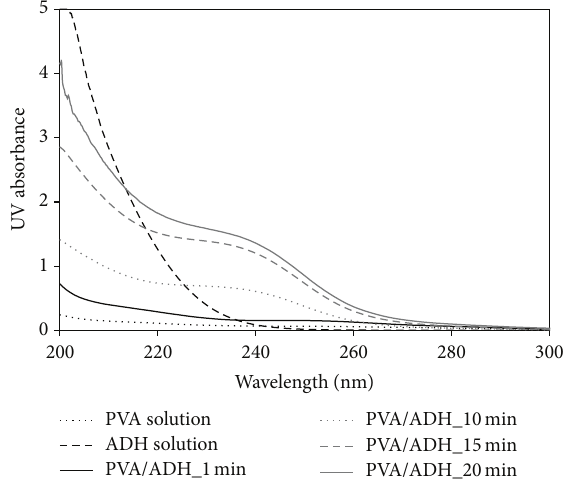
Figure 9: UV absorbance of ADH, PVA, and the PVA/ADH mix- tures with increasing degrees of gelation at 1, 10, 15, and 20 min (full gelation).